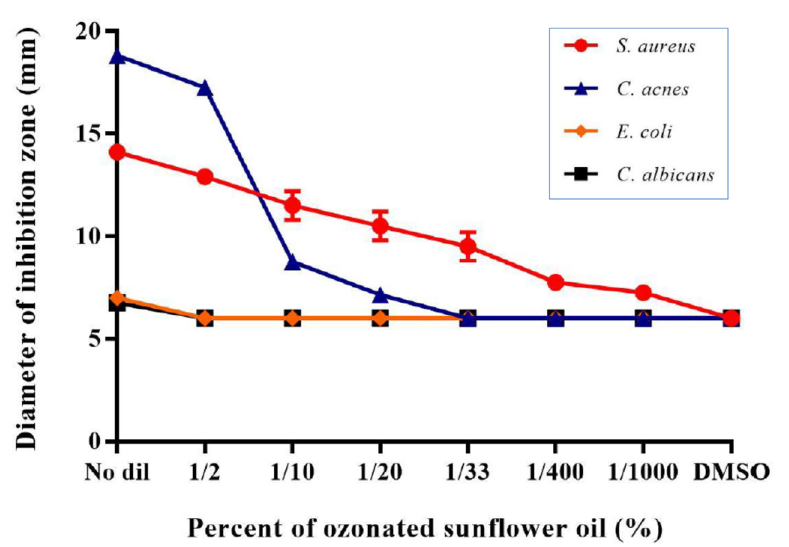
Figure 11. Inhibition of bacterial growth as diameter of inhibition zone in according to the concentration of ozonated sunflower oil. No dil, no dilution.